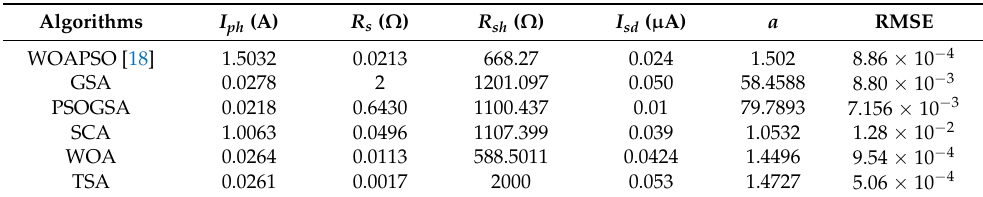
Table 2. Comparison of TSA with other parameter estimation methods for Photowatt-PWP201 PV Module. Algorithms